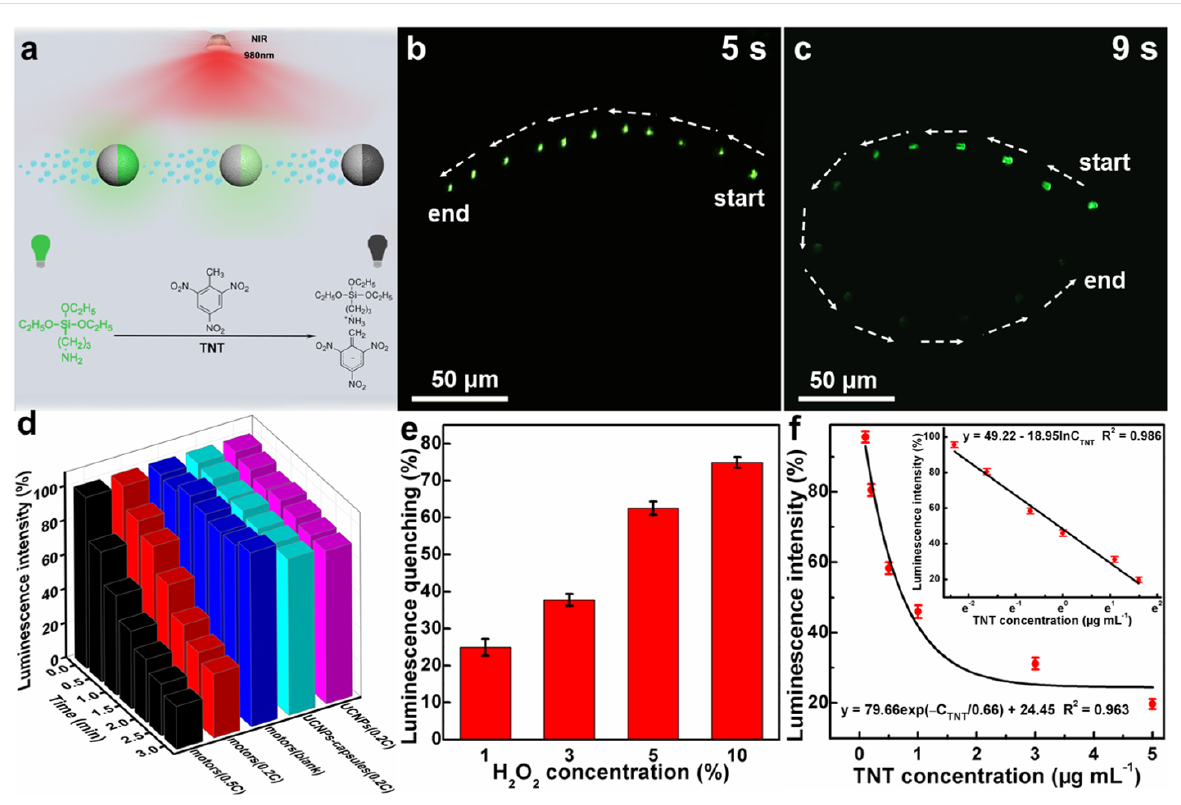
Figure 3: (a) Schematic illustration of the on–off luminescent detection of TNT by the Janus UCNP capsule motors. (b) Time lapse image of a Janus UCNP capsule motor in 5% H 2 O 2 without TNT in 5 s under a 980 nm laser excitation. (c) Time lapse image of a Janus UCNP capsule motor in 5% H 2 O 2 with 0.5 mg mL − 1 of TNT in 9 s under 980 nm laser excitation. (d) Time-dependent luminescence quenching of different samples in TNT solution with different concentrations ( c = 1 μ g mL − 1 ). (e) Plot of the luminescence quenching effect of Janus UCNP capsule motors in different H 2 O 2 concentrations with a TNT concentration of 0.2 μ g mL − 1 for 3 min. (f) Luminescence intensity of a Janus UCNP capsule motor after autonomous movement for 1 min in a TNT solution in response to the TNT concentration and the resultant fitting equation. The inset demonstrates a linear rela- tionship between the luminescence intensity of the Janus UCNP capsule motors and the natural logarithm of the TNT